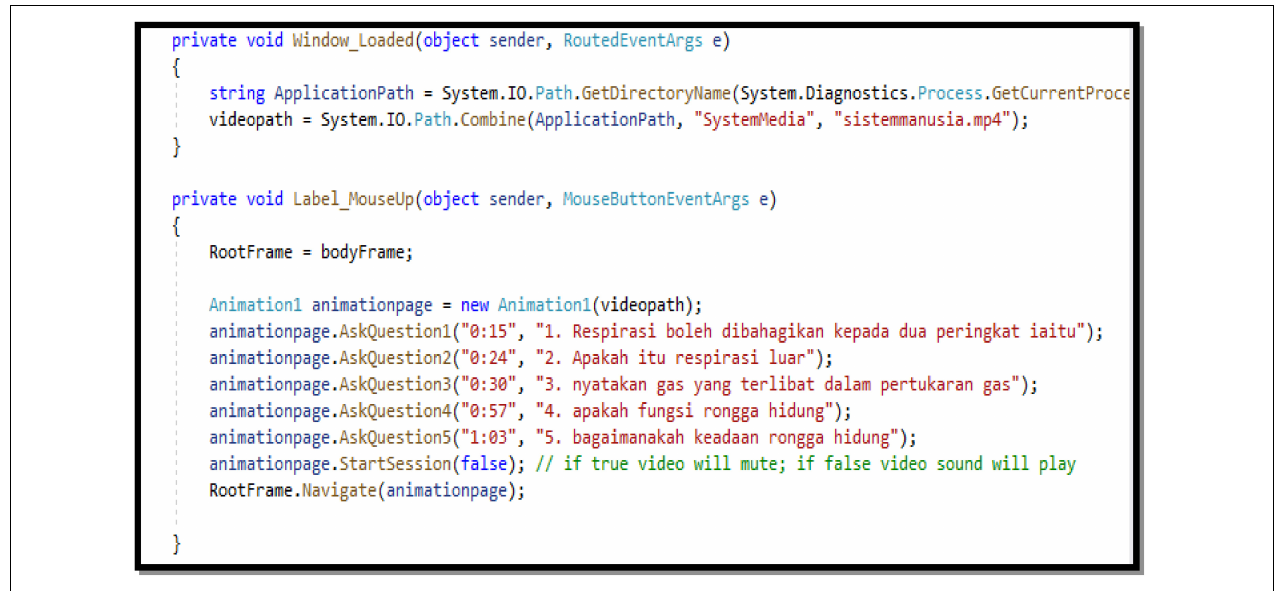
FIGURE 3 | Text-based programming in see, pause, and answer module.